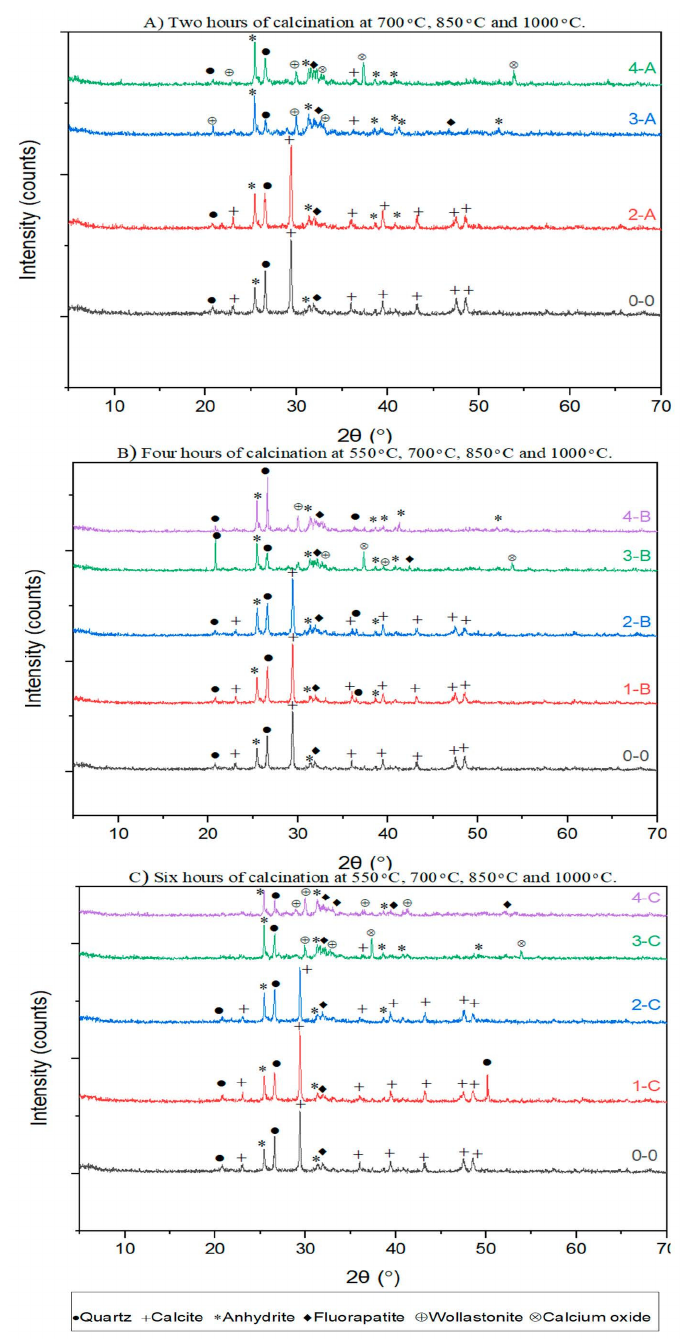
Figure 4. Comparison between XRD- patterns for ash treated at different temperatures with specific calcination durations.